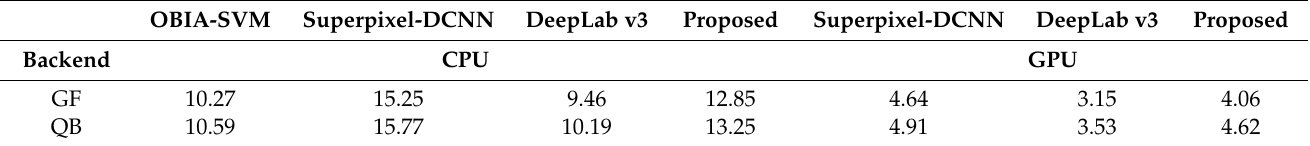
Figure 9. Qualitative classification of the competitive and proposed methods on QB. Table 5. Time complexity comparisons on GF and QB. The unit is second